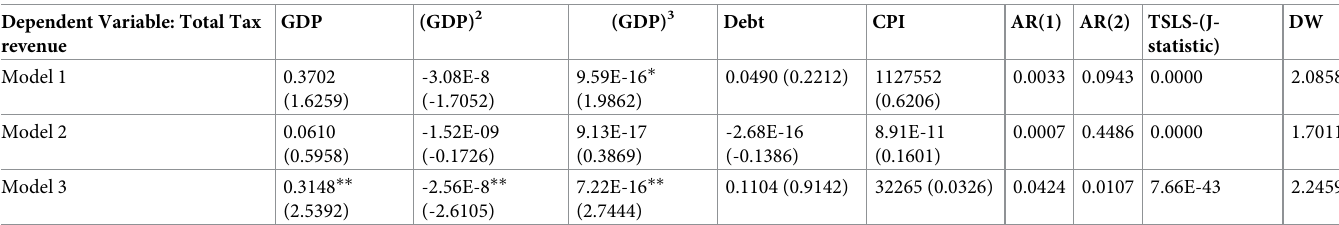
Table 5. Estimation results of